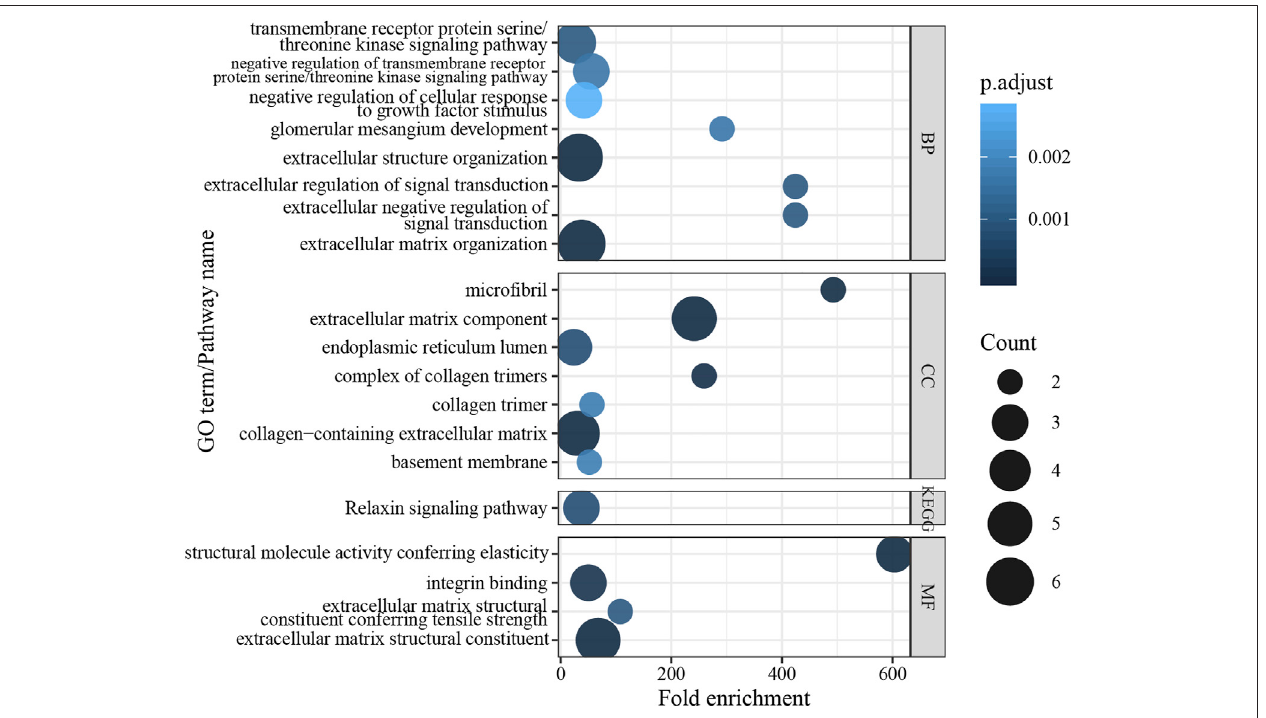
FIGURE 4 | Results of enrichment analysis in GO term and KEGG